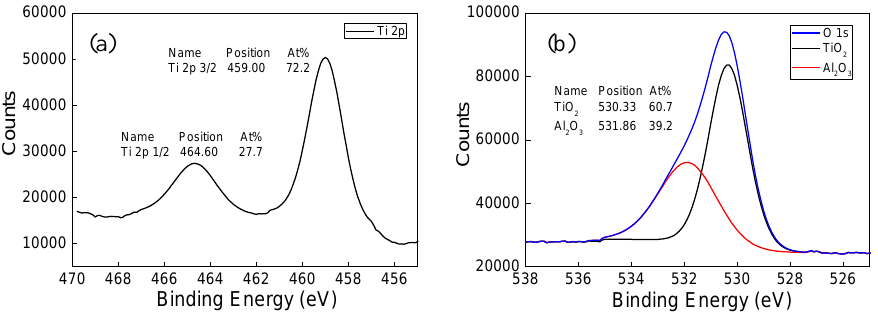
Figure 8. XPS spectra of the ( a ) Ti 2p peak and ( b ) O 1s peak on the surface of the 20 mm EBM-built Ti64 sample.